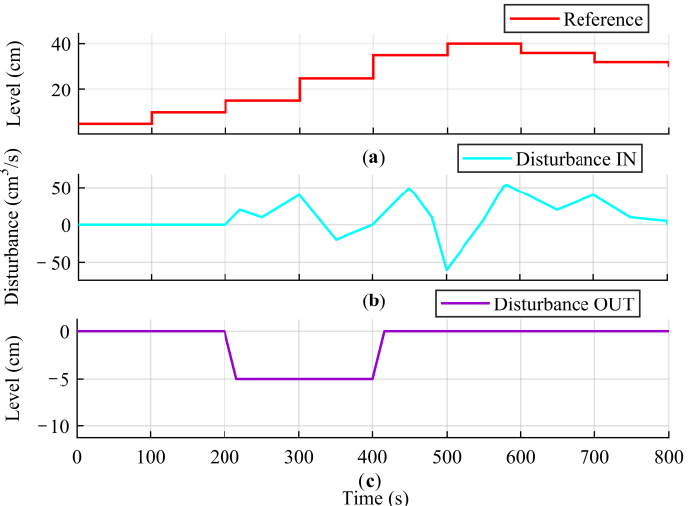
Figure 13. Test signals for verifying the performance of the controllers. ( a ) Variable reference. ( b ) Perturbation introduced at the input of the system (supply disturbances). ( c ) Perturbation introduced at the output of the system (load disturbances).